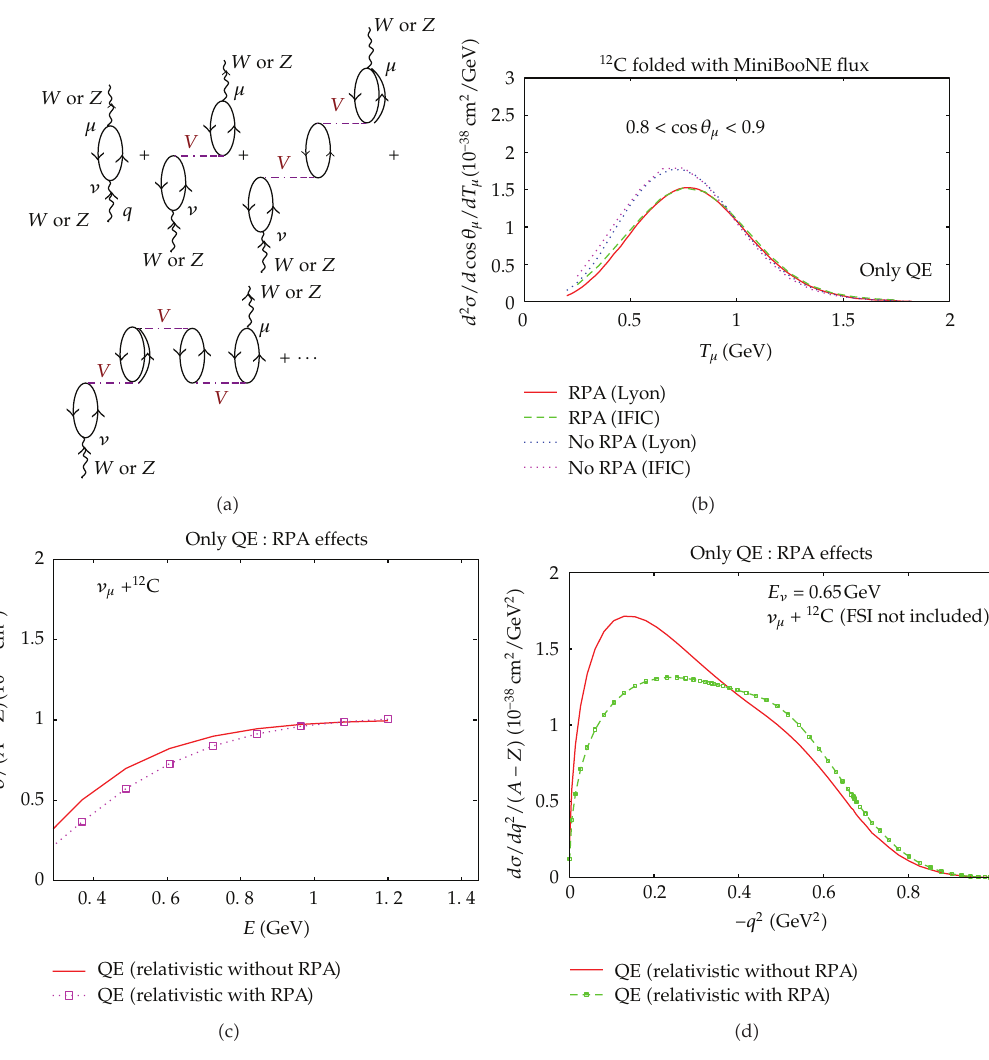
Figure 3: (cid:4) a (cid:5) Set of irreducible diagrams responsible for the polarization (cid:4) RPA (cid:5) e ff ects in the 1p1h contribution to the W or Z self energies. (cid:4) b (cid:5) MiniBooNE flux-averaged CC quasielastic ν μ − 12 C double di ff erential cross section per neutron for 0 . 8 < cos θ μ < 0 . 9 as a function of the muon kinetic energy. (cid:4) c, d (cid:5) Di ff erent theoretical predictions for muon neutrino CCQE total cross section o ff 12 C, as a function of the neutrino energy (cid:4) c (cid:5) and q 2 (cid:4) d (cid:5) , obtained from the relativistic model of (cid:6) 29, 30 (cid:7) . In all cases M A ∼ 1 .